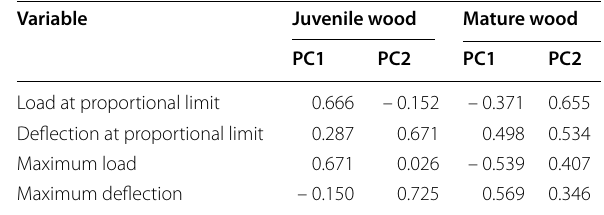
Table 9 Loading values of principal component analysis for six families